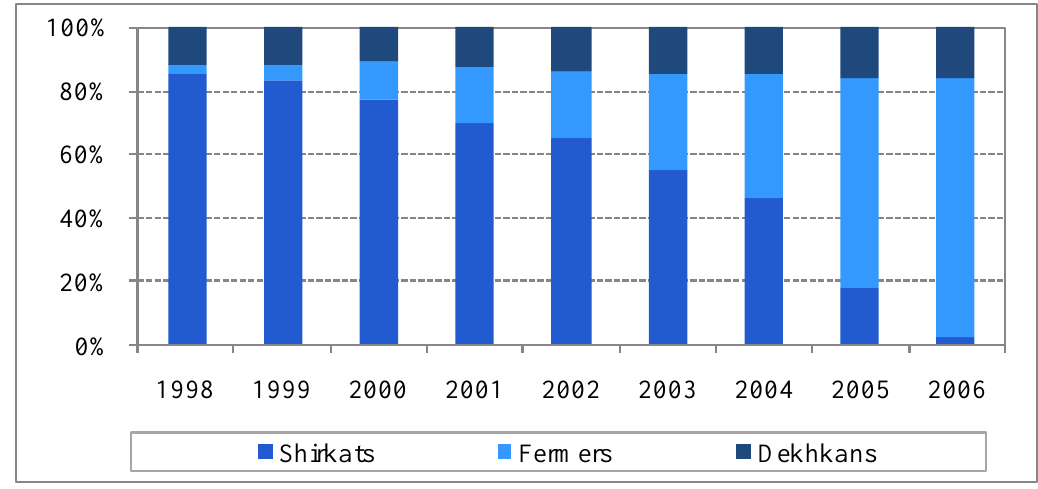
Figure 5. Change in the share of different entity types in total cropped land (in %) over time in the Khorezm